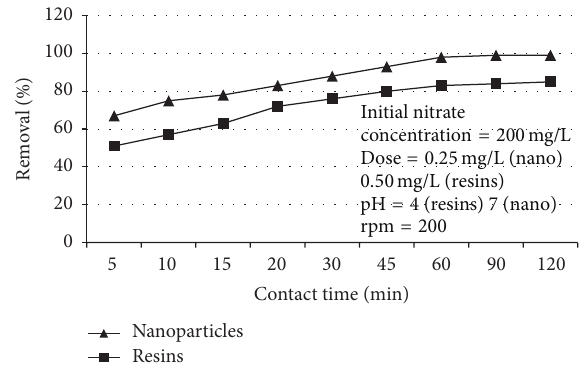
Figure 4: Effect of contact time on nitrate removal by resins Fe/Pt bimetallic